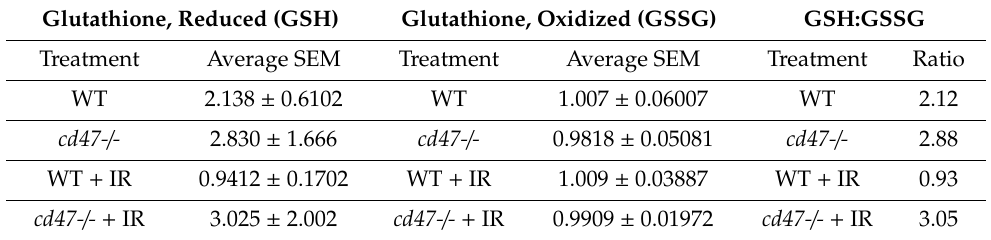
Figure 2. Regulation of glutathione metabolism. ( A ) Reduced (GSH) and ( B ) oxidized (GSSG) glutathione were measured along with metabolite precursors ( C ) (S-methylglutathione) and ( D ) 5-oxoproline. Symbols denote outliers. (* p < 0.05, n = 7–8). Table 1. Levels and ratios of reduced and oxidized glutathione.